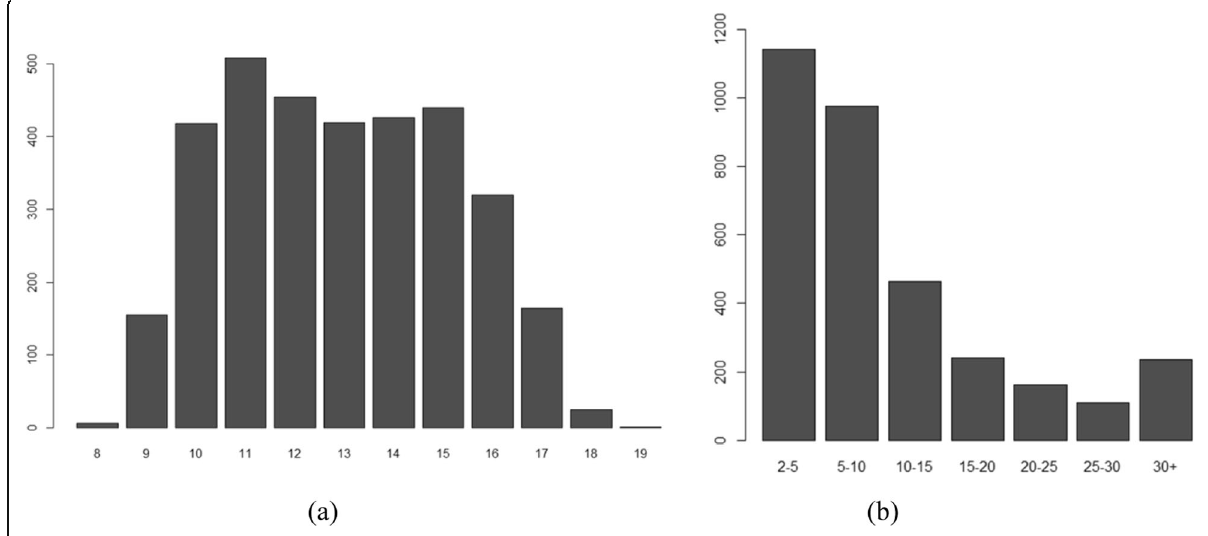
Fig. 3 Distribution of the stop time between 8 am and 7 pm ( a ) and of the stop durations in minutes ( b )